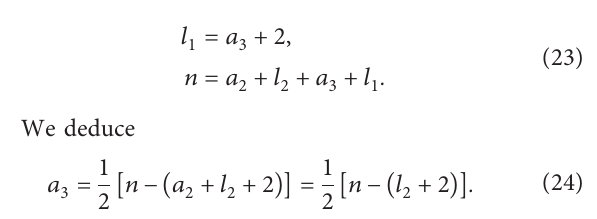
Figure 6: Catacondensed pentagonal system E